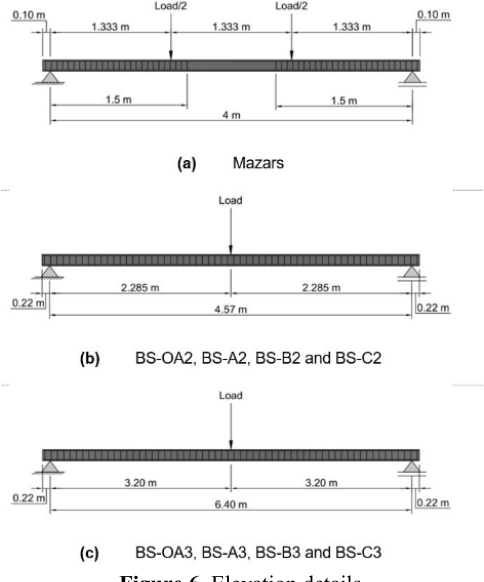
Figure 6. Elevation details.